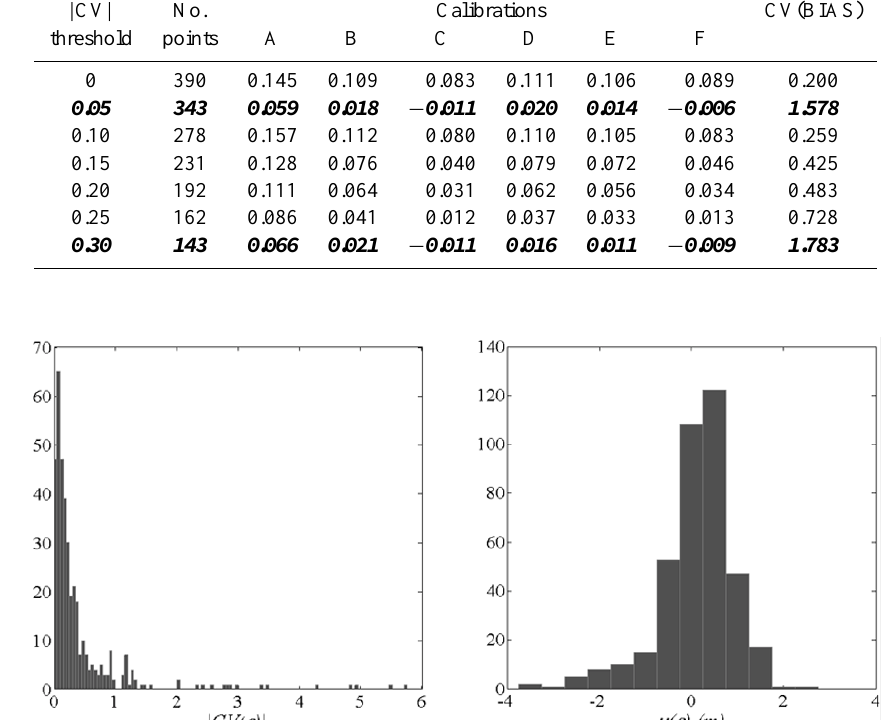
Figure 4. Histograms of absolute coefficient variation and mean of the errors of different calibration runs for every calibration point.